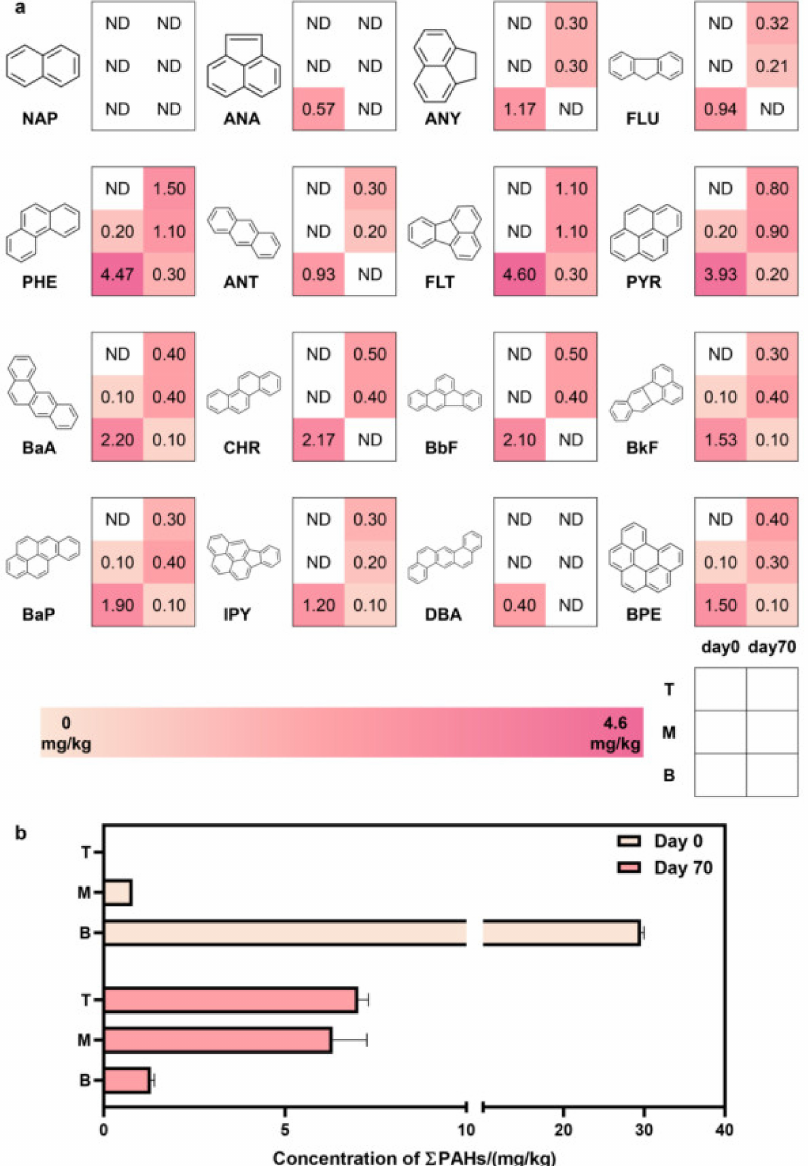
Figure 1. Concentrations of 16 PAHs ( a ) and total PAHs ( b ) in coking site soils sampled at depths of 0–10 cm (T: top layer), 10–30 cm (M: middle layer), and 30–100 cm (B: bottom layer) on Day 0 (in light color) and Day 70 (in dark color). Average concentration per kind of PAH is labeled in the corresponding cell and ND denotes not